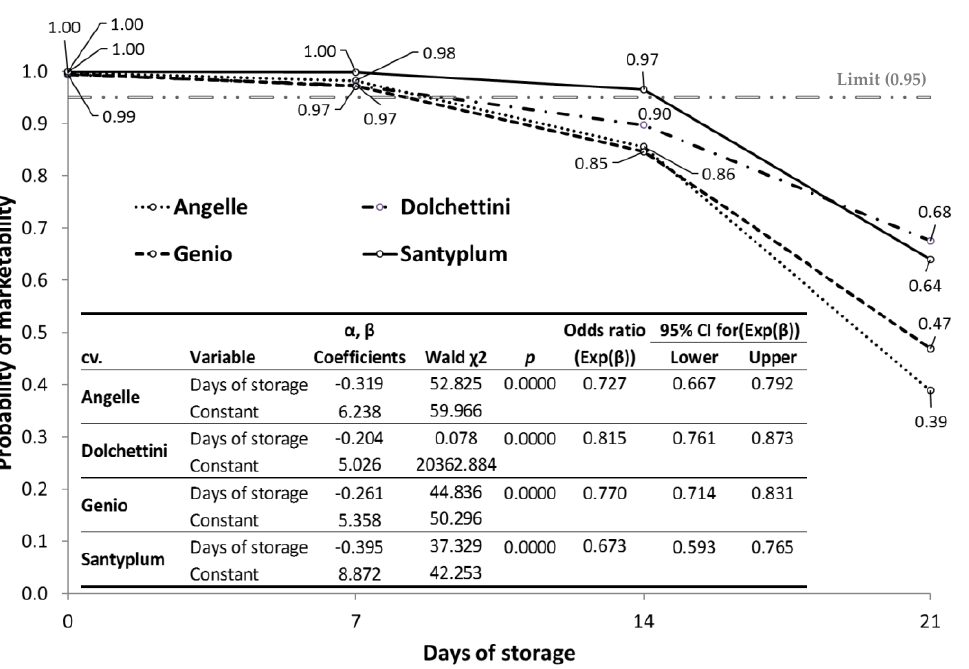
Figure 2. Temporal evolution of the marketability probability for the studied cherry tomato cultivars. The results originate from the simple independent logistic model for each cultivar based on the days of storage. The Hosmer and Lemeshow test: p > 0.05.